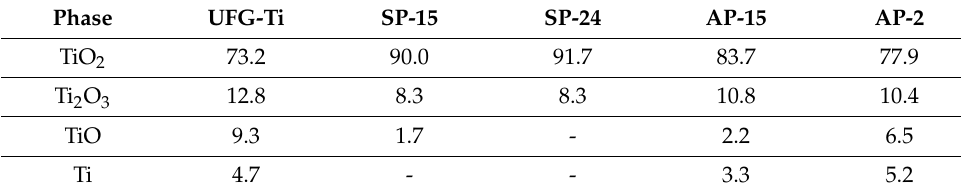
Table 2. Percentage of Ti forms based on Ti2p spectra deconvolution.